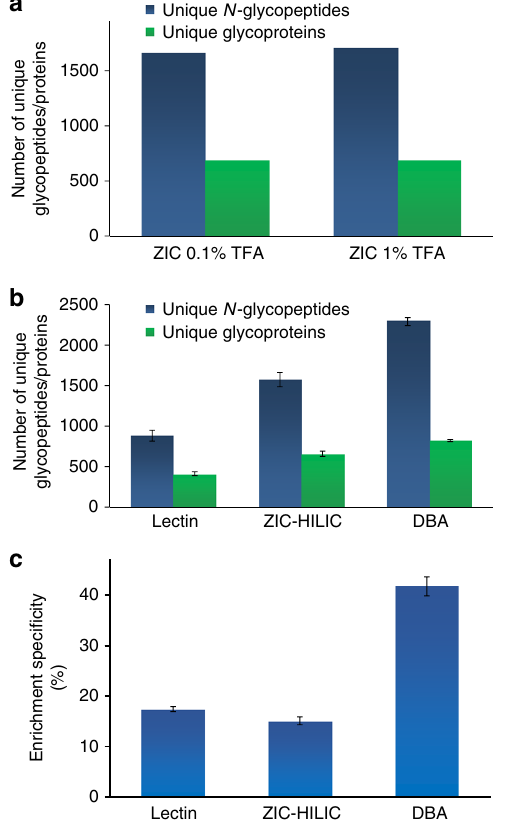
Fig. 3 Comparison of three enrichment methods. a Optimization of the concentrations of TFA as the ion-pairing reagent for ZIC-HILIC enrichment. b The numbers of unique glycopeptides (dark blue) and glycoproteins (green) identi fi ed using each of the three methods (lectin, ZIC-HILIC, and DBA) from parallel experiments. c Comparison of the enrichment speci fi city for three enrichment methods. The error bar represents the standard error of the mean calculated from triplicate